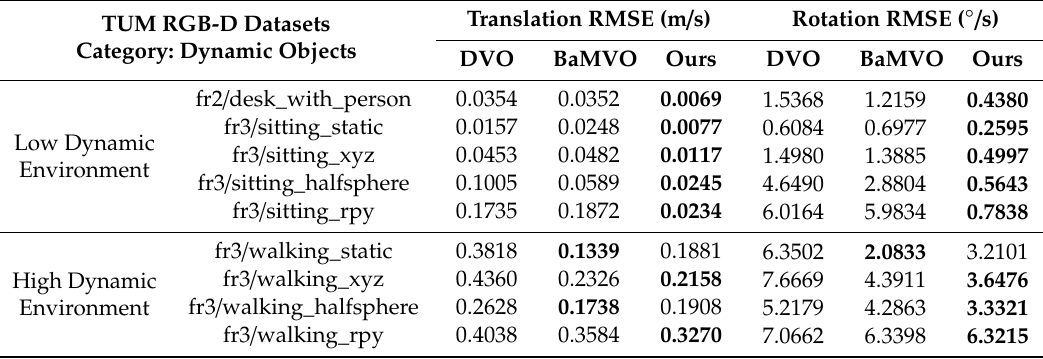
Table 4. Translation RMSE and rotation RMSE of relative pose error (RPE) for TUM RGB-D datasets in the dynamic objects category. The numbers in bold indicate that these terms are better than those of another